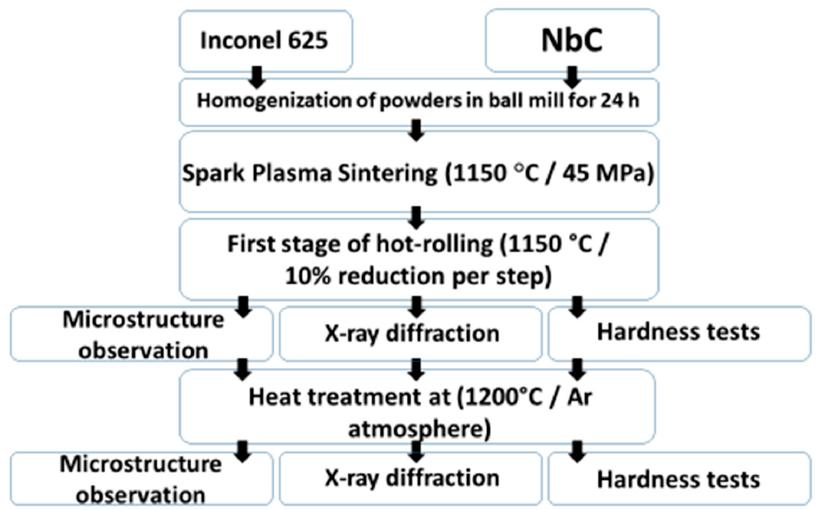
Figure 1. Schematic representation of the experimental procedure.